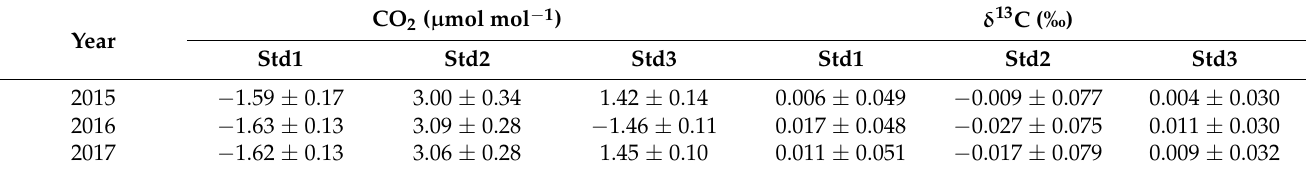
Table 1. Validation data for the multi − inlet CO 2 and its δ 13 C vertical profile sampling